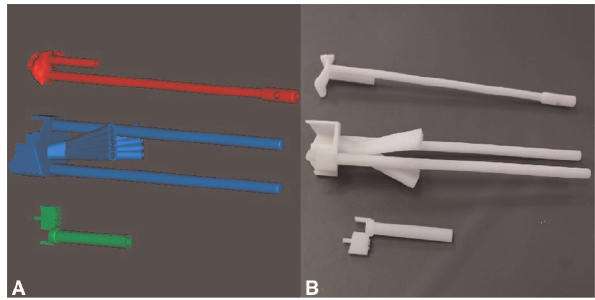
Figure 4 - A diagram showing the digital and realistic templates. A Digital 3D models of Templates A (red), B (green) and C (blue). B Realistic 3D models of the same